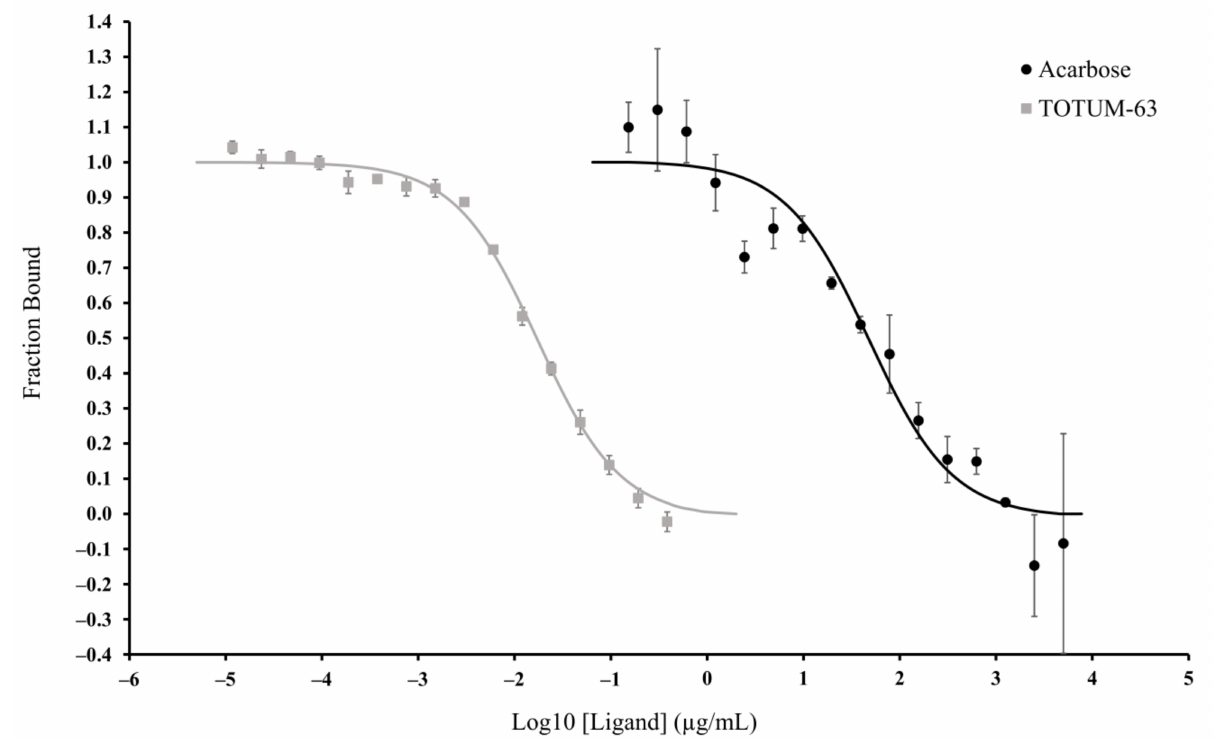
Figure 5. Fraction of TOTUM-63 and acarbose bound to α -glucosidase, measured by MST. Values are the mean ± SEM. n = 2 or 3 for all points in both groups. Raw fluorescence (in counts) for TOTUM-63 and variation of the normalized fluorescence ( ∆ FNorm, in ‰) for acarbose were normalized by expressing them as the fraction bound to the target.